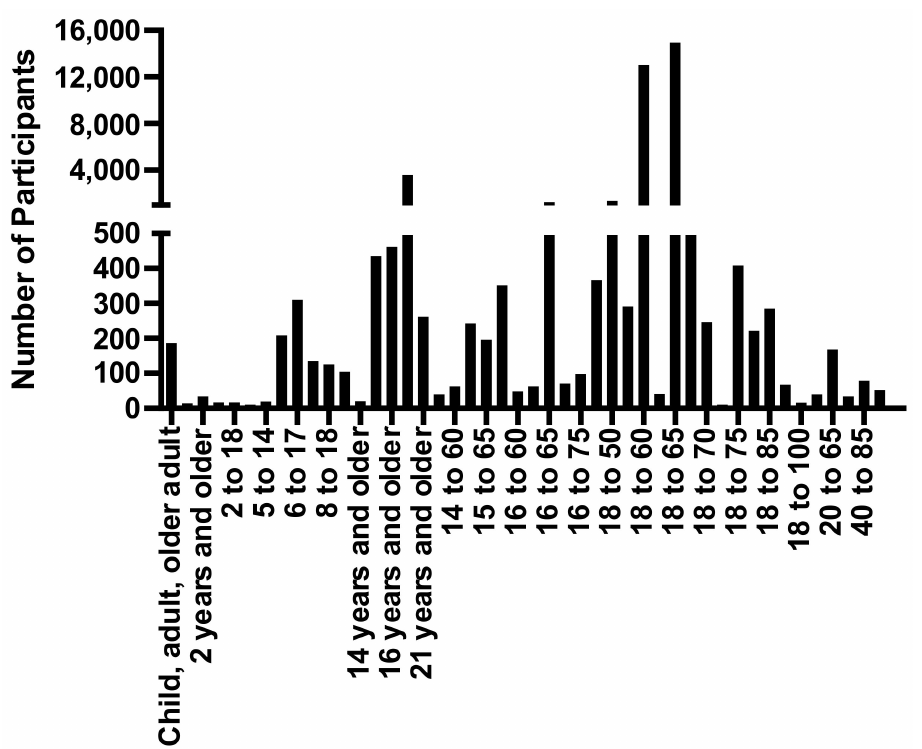
Figure 3. Number of participants for clinical trials in TBI and their age groupings in the completed studies. Note: y axis breaks at 500 participants.